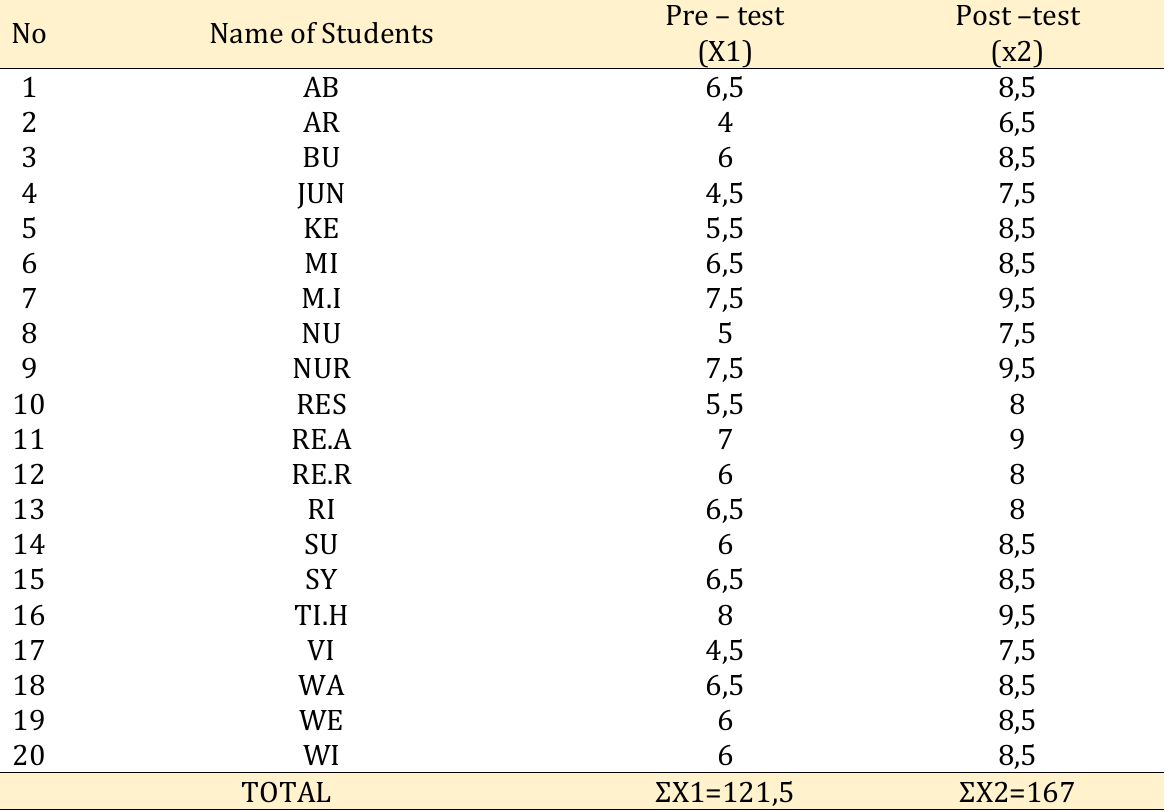
Table 1. The students’ score o f pre-test (X1) and post-test (X2)